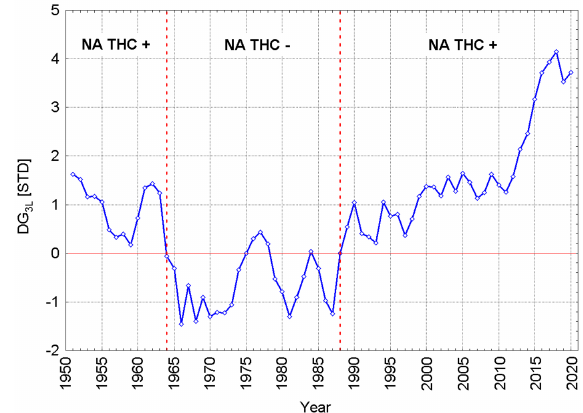
Fig. 8. The standardised DG index characterising the 3L intensity of heat transport through the thermohaline circulation (NA THC) from the Atlantic tropics to the Arctic. Vertical dashed lines mark the NA THC phase changes. The index values were calculated based on the ERSST v.5 dataset. NA THC, North Atlantic thermohaline